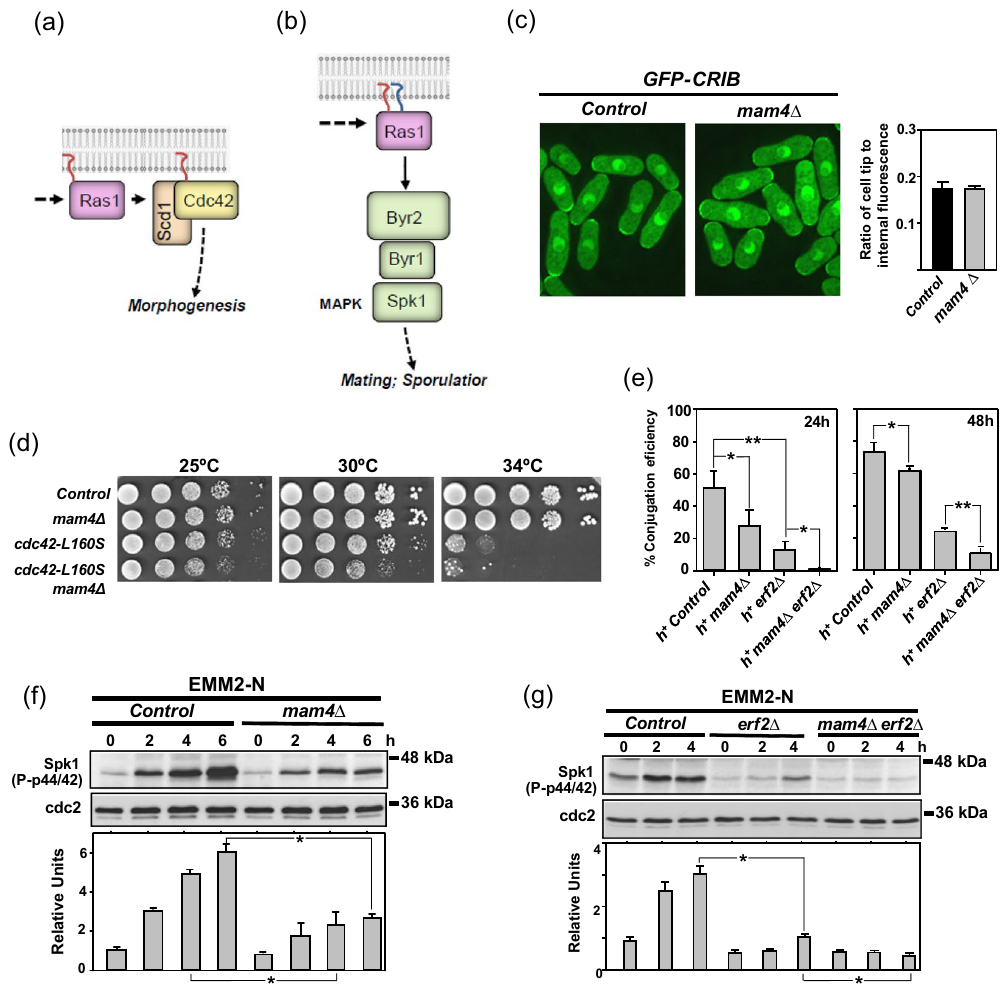
Figure 4. Cysteine methylation is important to regulate sexual differentiation mediated by palmitoylated Ras1. ( a ) In fission yeast cellular morphogenesis is regulated by unpalmitoylated Ras1 from endomembranes. ( b ) Pheromone signaling is modulated by plasma membrane-tethered and palmitoylated Ras1 to activate MAPK Spk1. ( c ) Deconvolved images of cells from control and mam4 ∆ strains expressing a GFP-CRIB fusion (GTP- bound Cdc42) were grown in YES medium and observed by fluorescence microscopy. ( d ) Serial dilutions of suspensions of control, mam4 ∆ , Cdc42 -L160S , and mam4 ∆ Cdc42 -L160S strains were spotted on YES plates and incubated at either, 25, 30, and 34 °C for 3 days. Results representative of three independent experiments are shown. ( e ) Control, mam4 ∆ , erf2 ∆ , and mam4 ∆ erf2 ∆ strains of the h + mating type were mixed with wild type h − cells, poured on SPA plates, and incubated at 25 °C. The percentage of conjugation efficiency (as mean ± SD) was determined after 24 and 48 h of incubation by microscopic counting of number of vegetative cells, zygotes, and asci. Biological triplicate samples ( ≥ 300 cells) were counted for each cross. ( f ) Control and mam4 ∆ strains were grown in EMM2 medium and transferred to the same medium lacking nitrogen source. TCA extracts were obtained from samples taken at different times, and activated Spk1 was detected with anti-phospho-p44/42 antibody. Relative units as mean ± SD for Spk1 activation (biological triplicates) were determined with respect to the internal control (anti-Cdc2 blot) at each time point. * P < 0.05. ( G ) Spk1 activation in cultures from control, erf2 ∆ , and mam4 ∆ erf2 ∆ strains was detected and quantified as described in ( f ). * P <